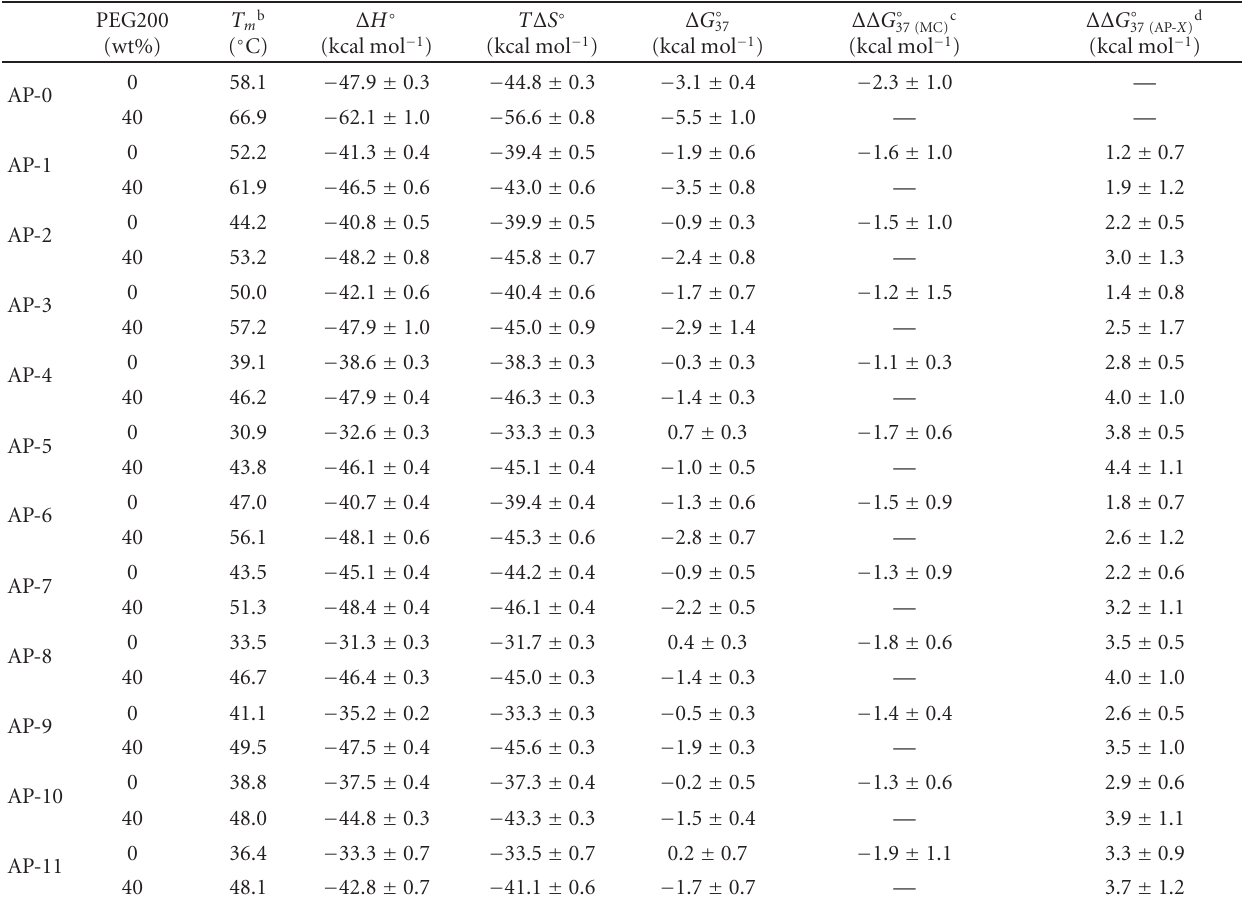
Table 2: Thermodynamic parameters of AP series for the formation of G-quadruplex a